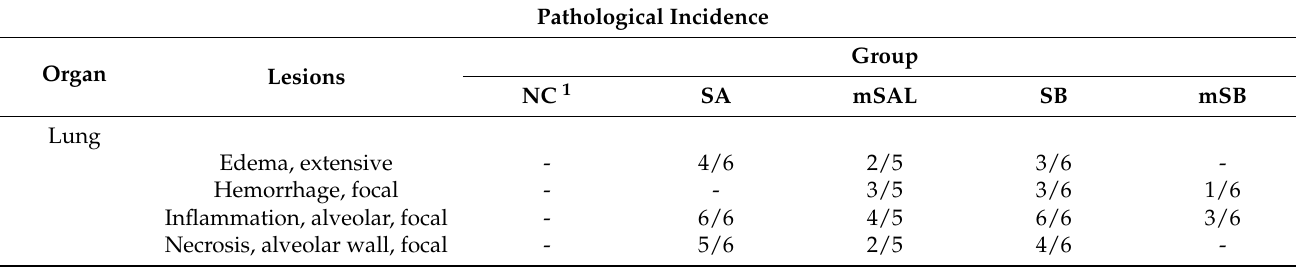
and modified nano-silica on Day 1.